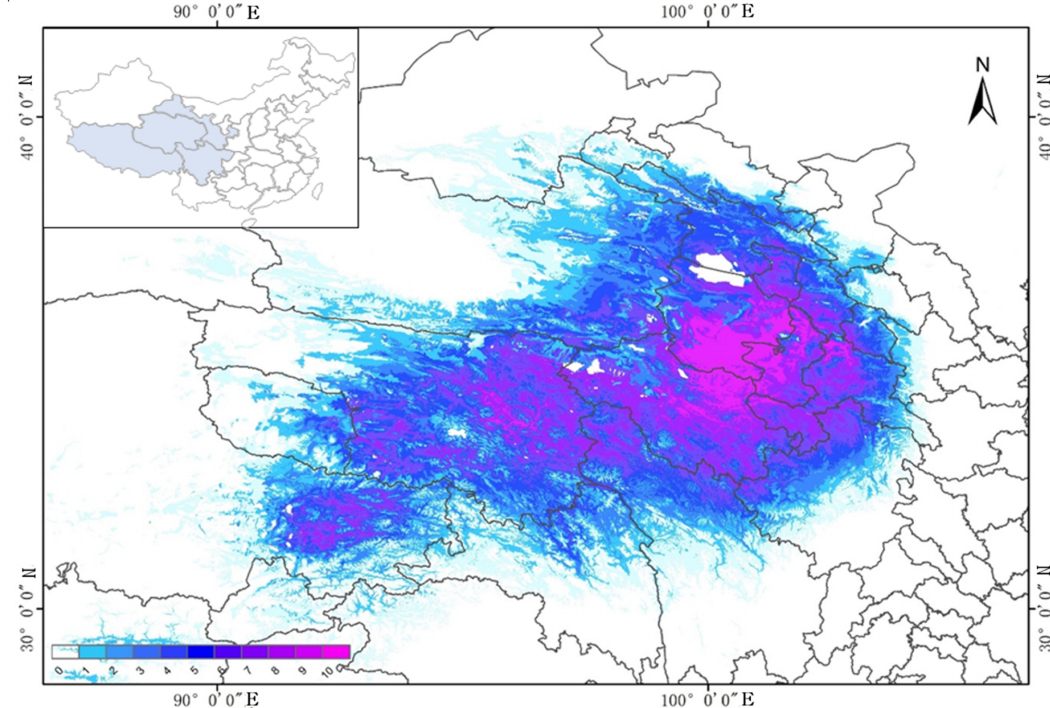
Figure 2. Current distribution of MaxEnt models for Pomatosace filicula. The icon 0–10 indicates that the higher the value, the more suitable the current habitat is for the growth of Pomatosace filicula